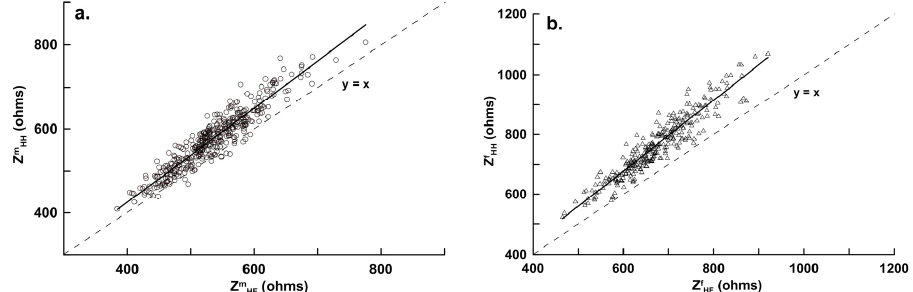
Figure 3. Correlations between Z HF (hand ‐ to ‐ foot impedance) with Z HH (hand ‐ to ‐ hand impedance) for ( a ) male subjects ( n = 403; Z mHH = 1.119, Z mHF − 22.065, r = 0.938, SEE = 24.229 ohms, p < 0.001); and ( b ) female subjects ( n = 301; Z fHH = 1.186, Z fHF − 33.970, r = 0.943, SEE = 34.021 ohms, p < 0.001). SEE, standard error of the estimate; r , coefficient of correlation. Table 2. Multiple regression analysis results for FFM DXA , based on BIA ‐ measured h 2 /Z HF and h 2 /Z HH Total subjects, n = 704; Male subjects (Modeling group, n = 269); Female subjects (Modeling group, n = 201).